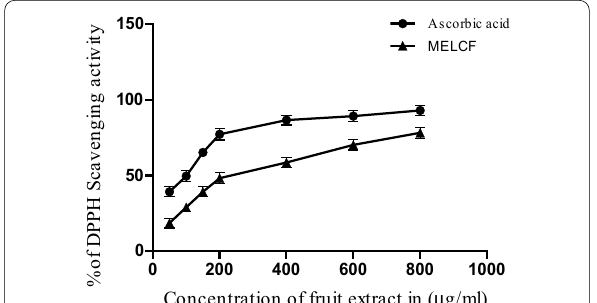
Fig. 3 In vitro DPPH free radical scavenging activity of ascorbic acid and MELCF. The values are represented as an average of triplicate trials, the error bars are SEM values